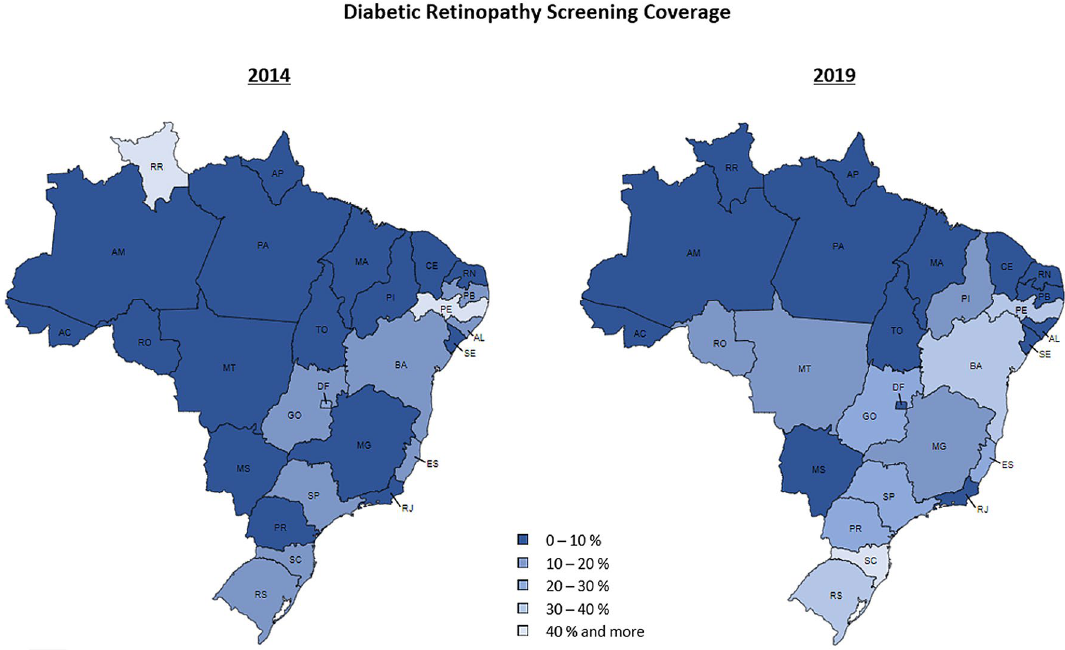
Figure 2. Diabetic Retinopathy Screening Coverage among Diabetic Patients through SUS in 2019, by state. Source: